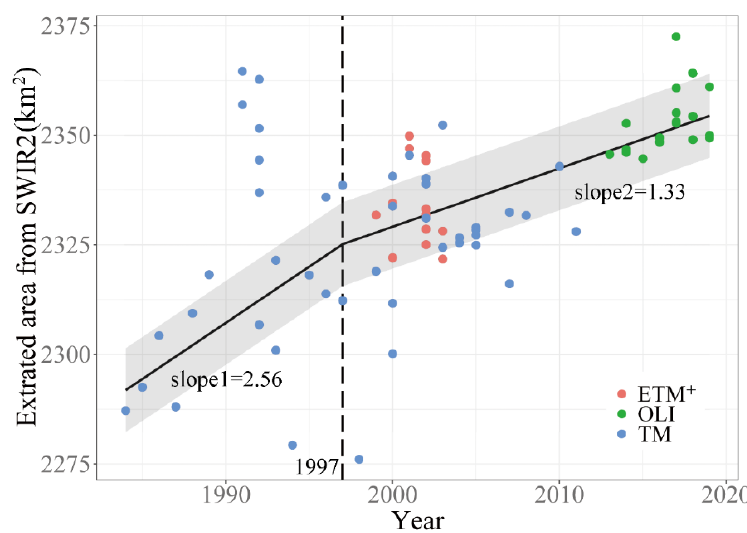
Figure 8. Temporal trend of extracted area in Taihu Lake from 1984 to 2019 (TM = Thematic Mapper; ETM + = Enhanced Thematic Mapper ; OLI = Operational Land Imager ) .